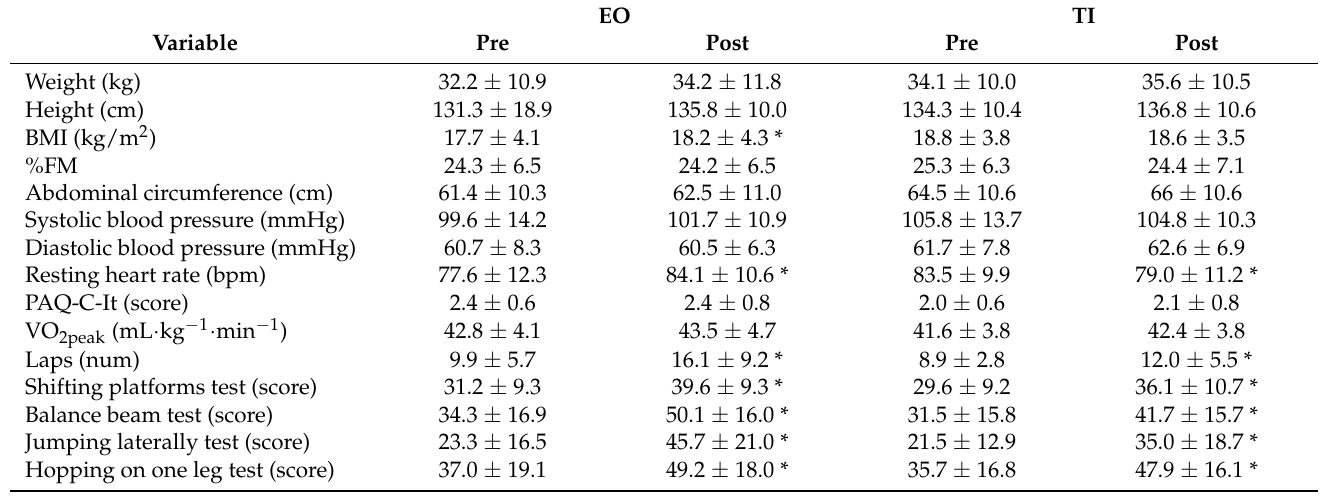
(Table 2). The time × gender interaction (F 1,102 = 5.05, p = 0.027, η 2 = 0.047) revealed that boys had a higher increase of VO 2peak than girls after intervention (Figure 2). Table 2. Pre- and post-intervention values (mean values ± SD) of experimental outdoor intervention (EO) and traditional indoor intervention (TI).